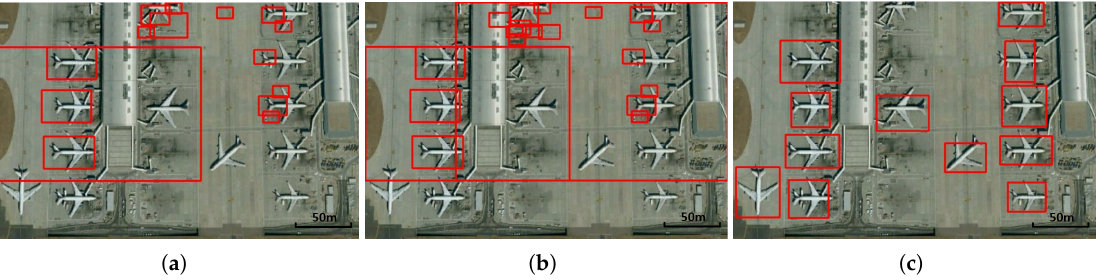
Figure 9. The detection results of different aircraft detection frameworks. ( a ) the detection result in the condition that the largest number of actions in HODRL [8] is set to 150; ( b ) the detection result in the condition that the largest number of actions in HODRL [8] is set to 200; and ( c ) the detection result generated by the RL-CNN detection